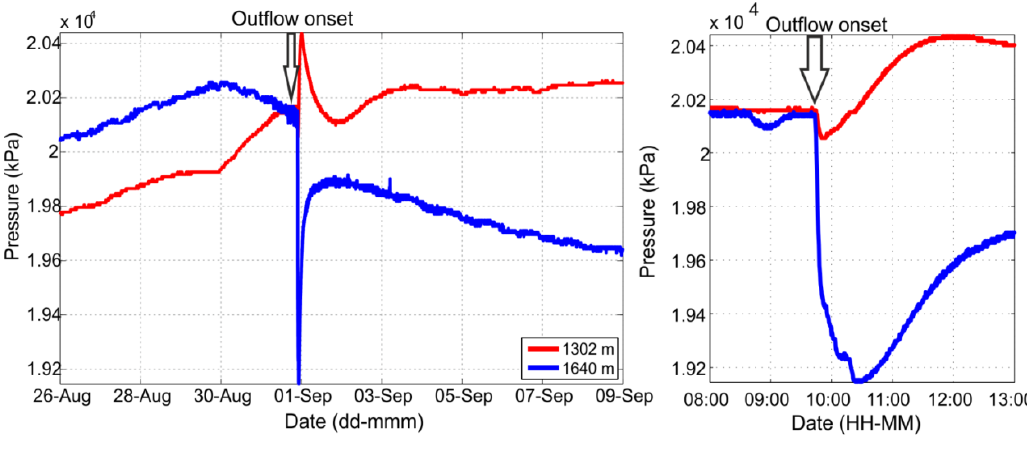
Figure 4. ( Left ): Pressure measured by the sensors inside the observation well during the two-week time period analysed in this study. ( Right ): Zoom on the pressure perturbations at the reported time of the CO leakage (1 September 2005, 2